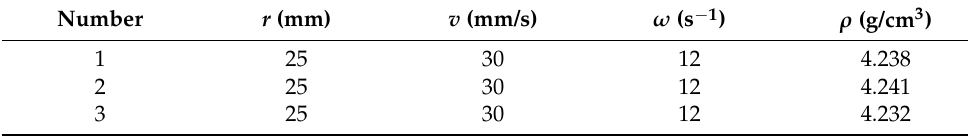
Table 9. Pollination experiment result